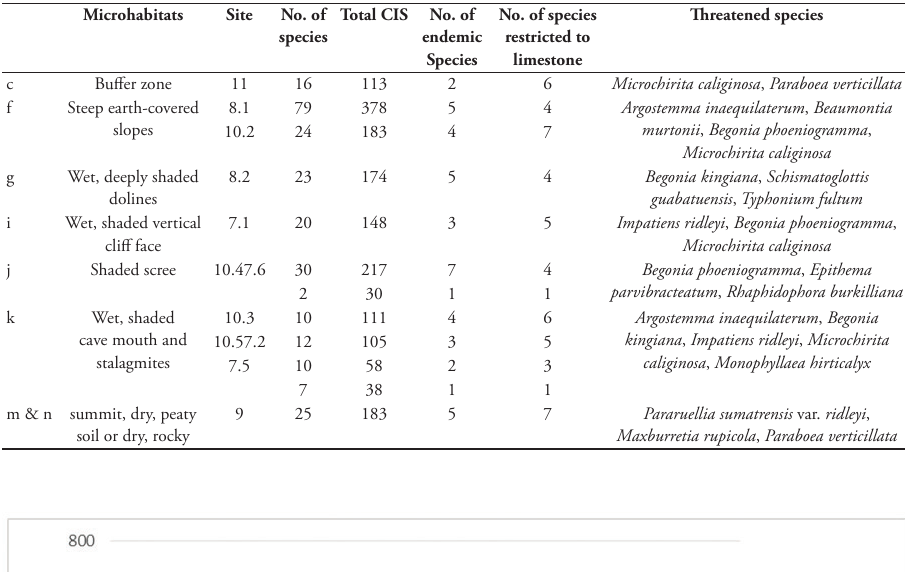
Table 7. Undisturbed microhabitats at Batu Caves with high conservation importance (based on the total Conservation Importance Score (CIS), presence of threatened, endemic and species restricted to limestone substrates).